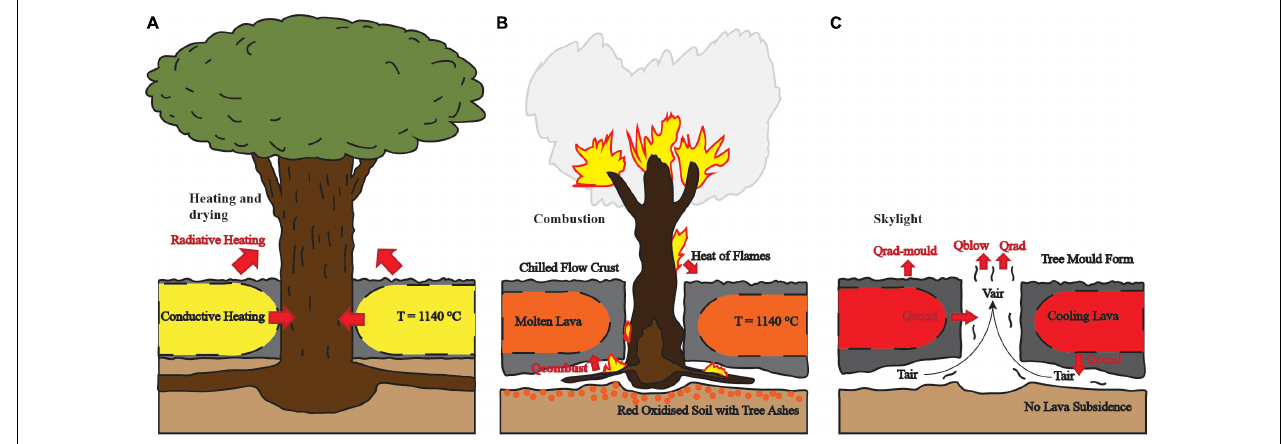
FIGURE 13 | Cartoon showing the three-step model for tree mold formation (cf. Figure 2 ): (A) heating and drying, (B) combustion, (C) skylight. Q heat , combustion heat loss; Q blow , tree mold heat loss; Q rad , radiative heat loss; Q conv , convected heat loss; Q cond , conducted heat loss; V air , air exit speed; T air , air temperature in the root mold (see